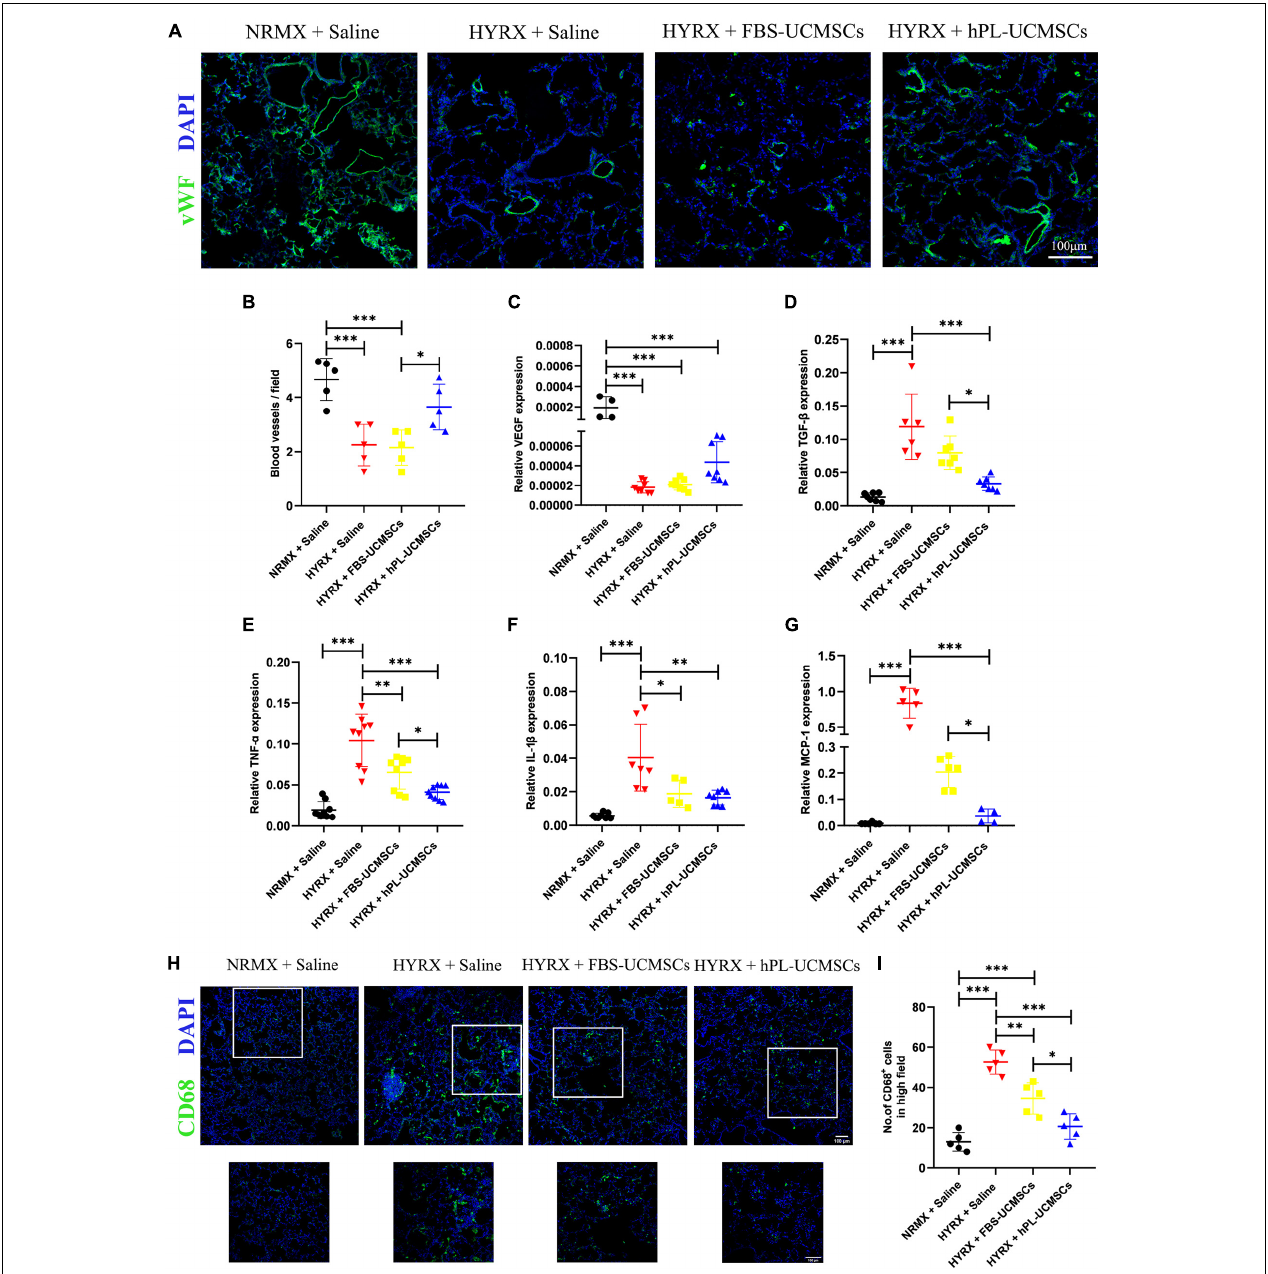
FIGURE 6 | Human platelet lysate-human umbilical cord-derived mesenchymal stromal cells treatment rescued hyperoxia-induced loss of microvessels and suppressed macrophages-induced inflammatory response. Microvessels in lung sections were analyzed by staining with von Willebrand factor (vWF) at PN10 (A) ; vWF-positive vessels that smaller than 50 µ m were counted in five random views (B) . Scale bars, 100 µ m. (C) The expression of vascular endothelial growth factor (VEGF) in lung tissue was analyzed by qPCR. (D) Rat TGF- β is related to lung fibrosis, so the TGF- β expression in treatment group was analyzed. TNF- α (E) and IL-1 β (F) are the major factors in lung inflammation post-BPD, and their expressions were analyzed. (G) Monocyte chemoattractant protein-1 (MCP-1) can recruit monocytes from blood vessel to lung tissues, the MCP-1 expression was also evaluated. CD68 + inflammatory macrophages in the lung tissue at PN10 post-BPD were determined under fluorescence microscopy (H) ; and calculated from five random fields of view for each experiment using a double-blind method (I) . Scale bars, 100 µ m. Data are shown as mean ± SEM. n = 5–10. ∗ p < 0.05, ∗∗ p < 0.01, ∗∗∗ p < 0.001.